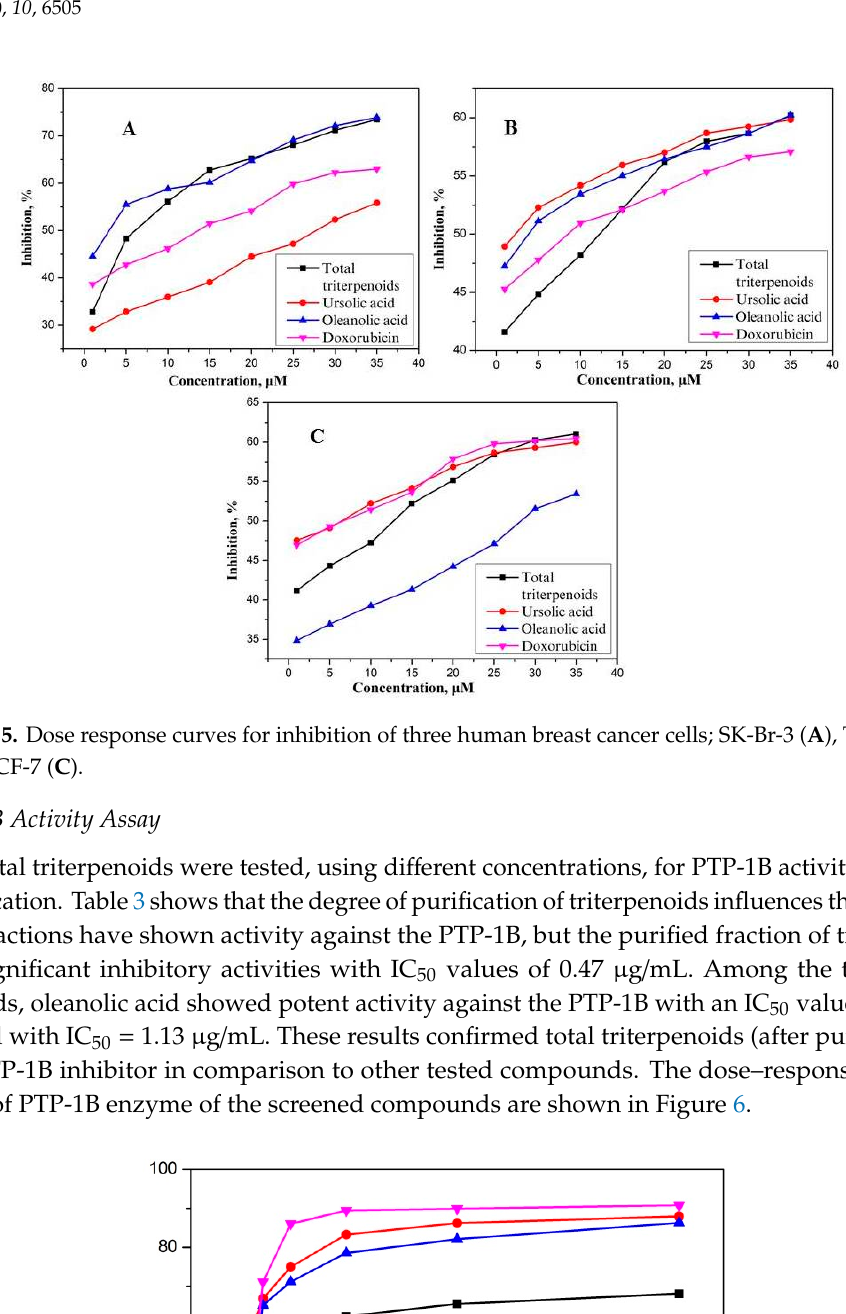
Table 3. Results of protein-tyrosine phosphatase (PTP-1B) inhibition of the total triterpenoids fractions and isolated two individual triterpenoids of D. heterophyllum .